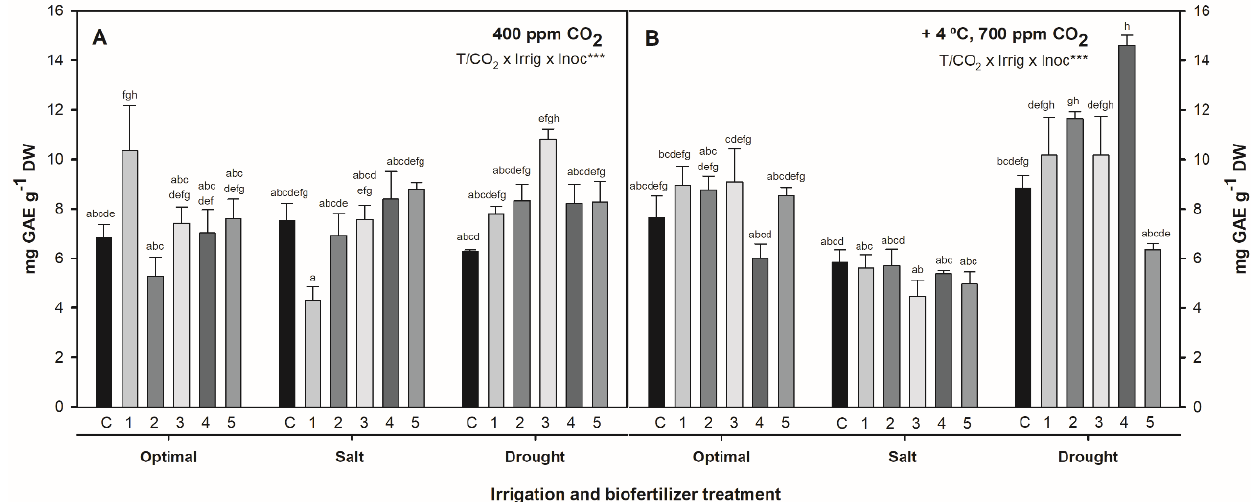
Figure 2. Total phenol content in S. ramosissima shoots, as expressed by mg GAE g −1 DW, after 30 days under irrigation (optimal 171 mmol L −1 NaCl, salinity 510 mmol L −1 NaCl, and drought) and inoculation (control non-inoculated — C, and biofertilizers 1 to 5) treatments in ( A ) 25/14 °C 400 ppm CO 2 chamber and ( B ) 29/18 °C 700 ppm CO 2 chamber. Values are means ± S.E. (n = 3). Different letters indicate means that are significantly different from each other (GLM: T/CO 2 × Irrigation × Inoculation, p < 0.001). “T/CO 2 × Irrig × Inoc” in the upper right corner of the panels indicates triple interaction significant effects ( p *** < 0.001).